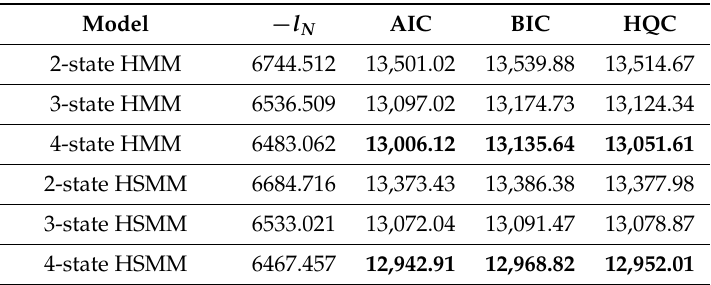
Table 4. Goodness-of-fit statistics of stationary normal HMMs and homogeneous normal HSMMs with negative binomial dwell-time distributions for 2,3, and 4 states based on the entire series of daily log returns of the S and P 500. Table reproduced from